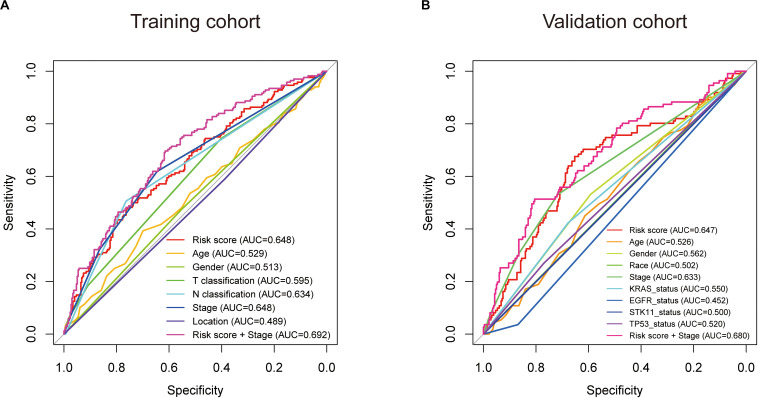
Receiver operating characteristic (ROC) analysis of the eight-gene signature risk score. ROC analysis of the sensitivity and specificity of the prognosis prediction by the eight-gene risk score, age, gender, race, T classification, N classification, tumor stage, tumor location, KRAS status, EGFR status, STK11 status, TP53 status, or risk score + tumor stage in training cohort (A) and validation cohort (B) based on overall survival. AUC, area under the ROC curve.